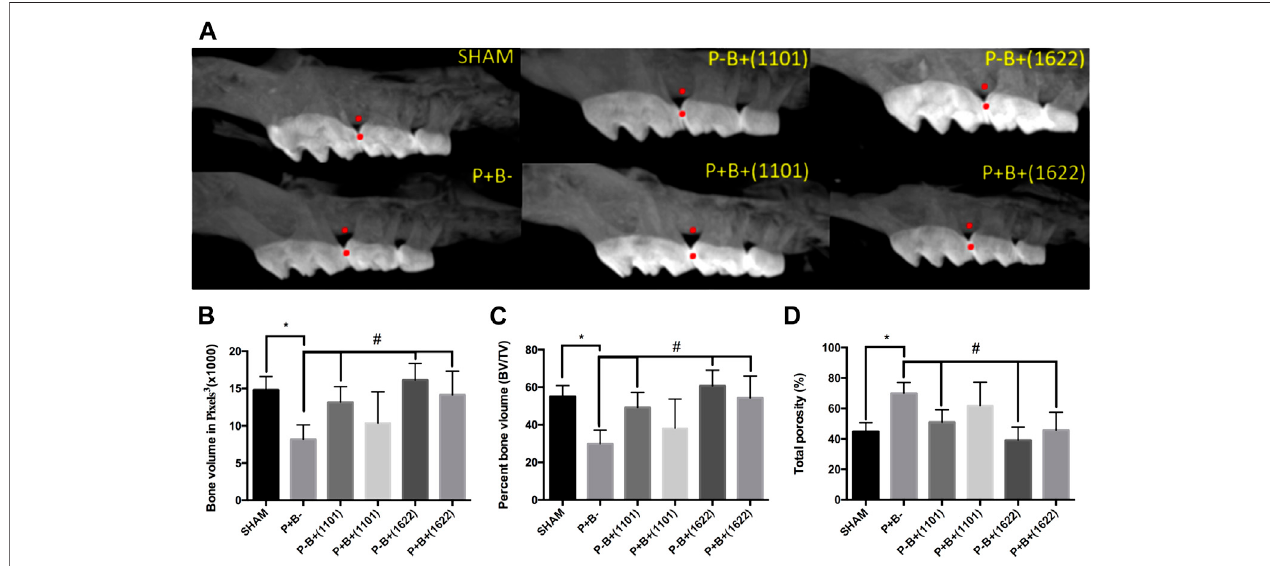
FIGURE2| Alveolarboneanalysisdetermined byMicrotomographyintheinterproximalregionof fi rstand second Mattheright maxillaofC57Bl/6micesubmitted to different treatments for 45 days: SHAM (negative control), P + B- (positive control), P-B+ (1101) ( B. breve 110 1A ), P + B+ (1101) (microbial consortium + B. breve 110 1A ),P-B+ (1622) ( B. bi fi dum 162 2A ) and P +B+ (1622) (microbialconsortium + B. bi fi dum 162 2A ). (A) Representative images ofalveolar bone.All data were obtained intheregionbetweentheredpoints. DataonAlveolarbonevolume (ABV)(Average andsd)determinedinpixels 3 (B) ,Percentageofalveolarbonevolume(Average and sd) and (C) Percentage of total porosity (Average and sd) (D) of the different groups. * Statistically signi fi cant difference in relation to negative control (SHAM), # Statistically signi fi cant difference in relation to positive control (P + B-). ANOVA, Tukey ’ s multiple comparison, p < 0.05%. Data representative of two independent experiments ( n (cid:1) 8 mice/per